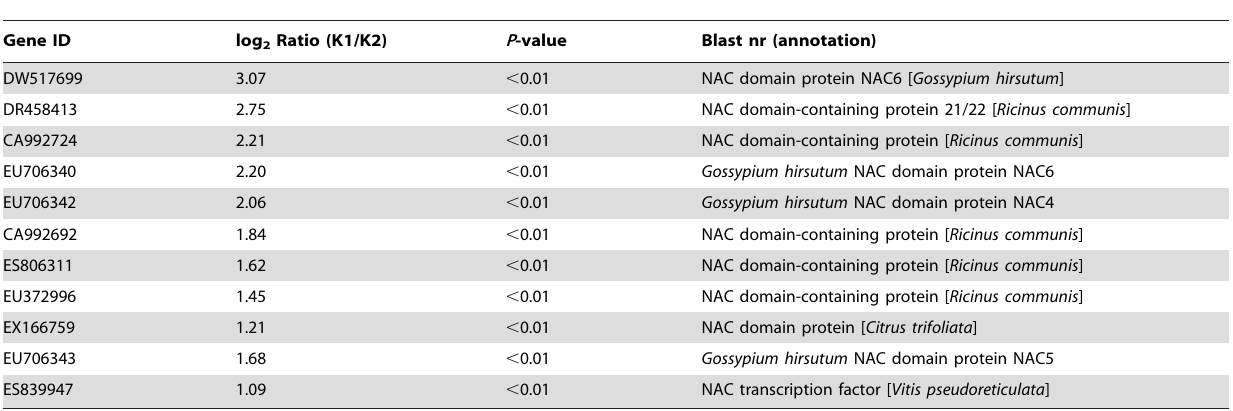
Table 5. Differently expressed NAC genes identified using Solexa sequencing in cotton.